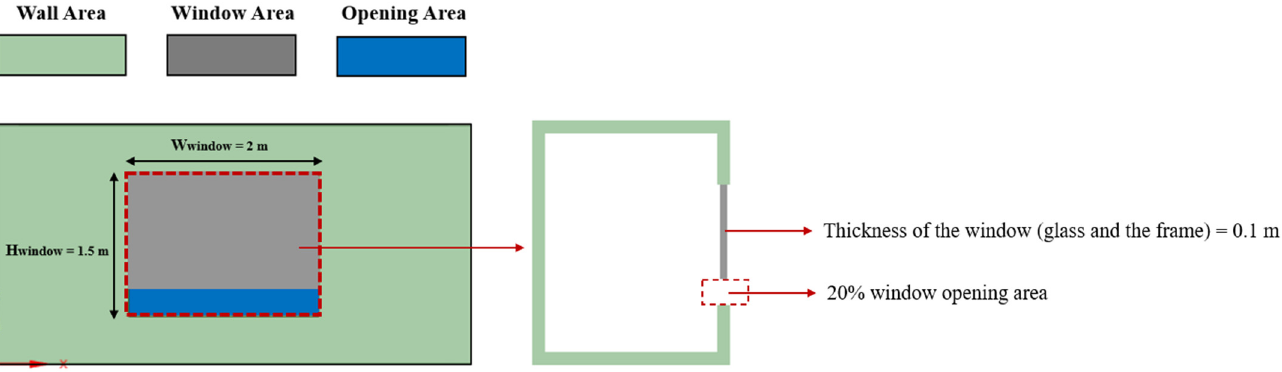
Figure 5. The dimension of each window and the opening area.